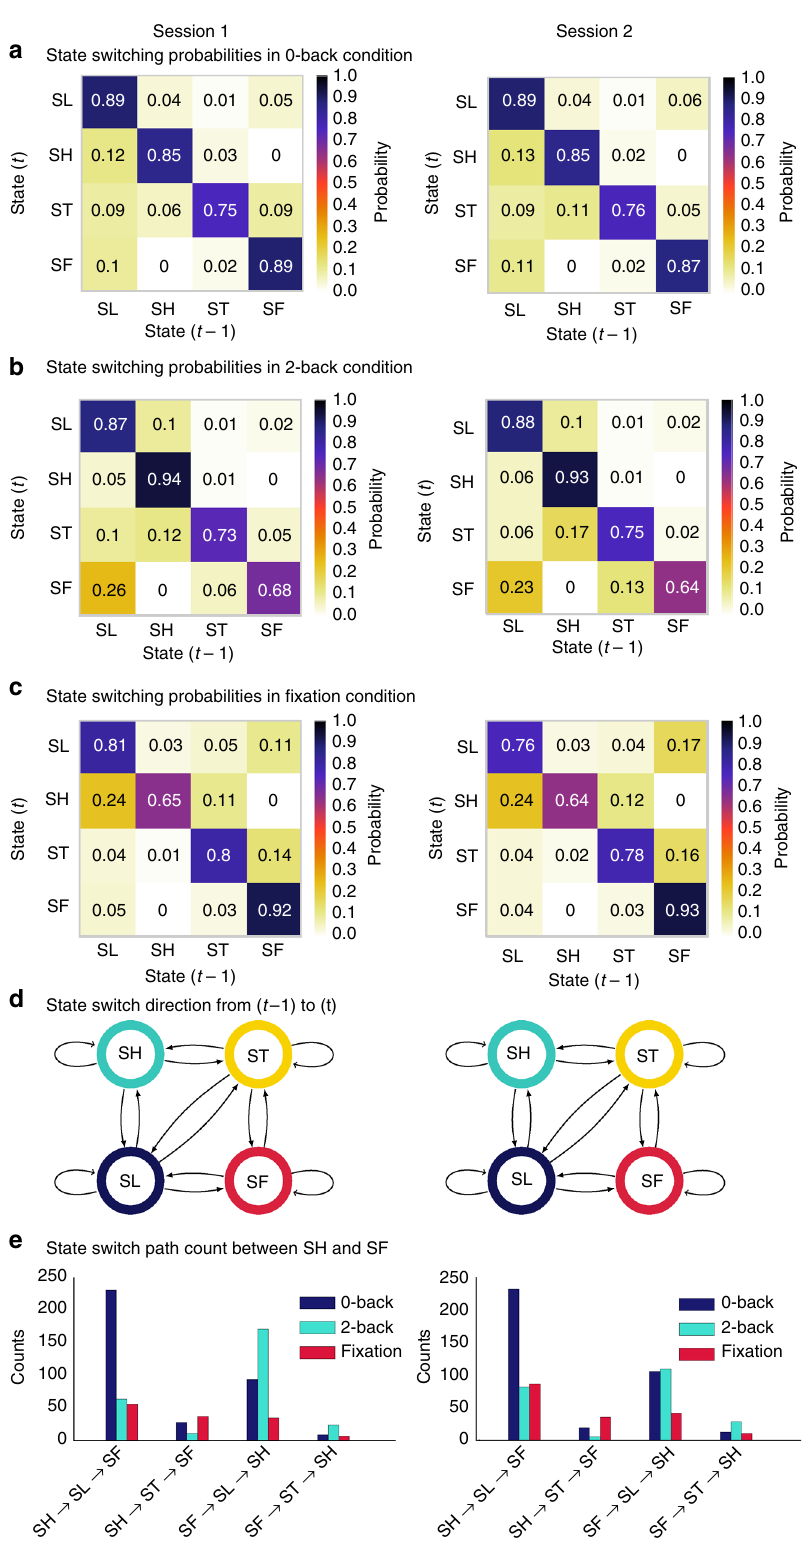
Fig. 5 Dynamic switching properties of latent brain states. a – c State transition probability, de fi ned as the probability that a latent brain state at time instance t stays in its own state or switches to other states at time instance t − 1, for each of the four latent states that were identi fi ed in the three task conditions. States are persistent over time in each of the task conditions, i.e., they are more likely to stay in their own state rather than to switch to other states in the next time point ( p s < 0.001, two-tailed t -test). d State transition probability diagram illustrating that the state SH, which dominates the 2-back task condition, does not switch directly to SF, the state which dominates the fi xation condition, and vice versa. As shown in a – c the transition probability between these states was zero. e Analysis of likely switching paths between SH and SF, revealed that these states fi rst pass through SL and